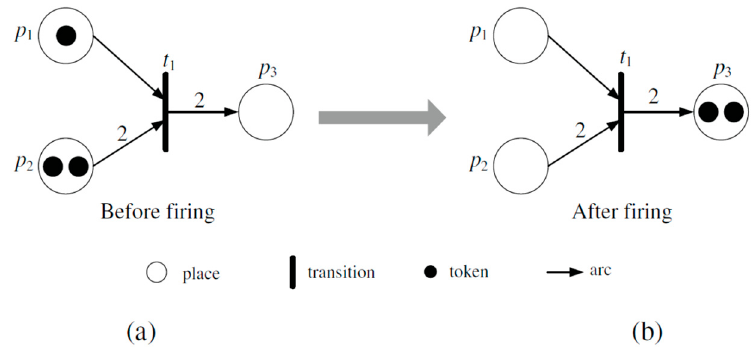
Figure 1. Example of Petri Nets: ( a ) Before firing tokens, ( b ) After firing tokens [16] .